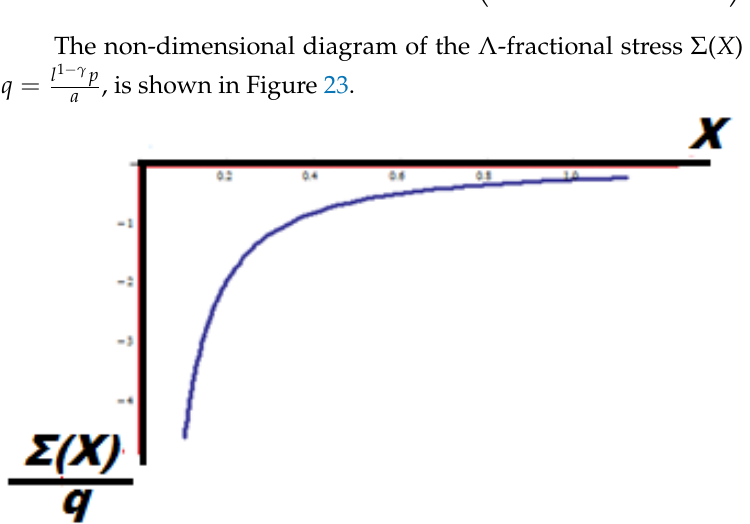
1 − γ p H is shown in Figure 24. a